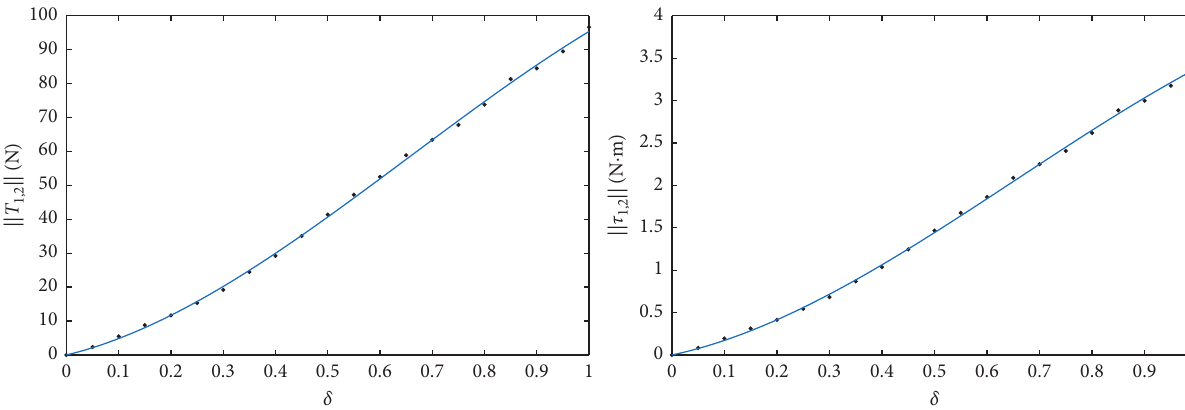
Figure 4: Measured values of the thrust and torque of the front motors versus the throttle δ .